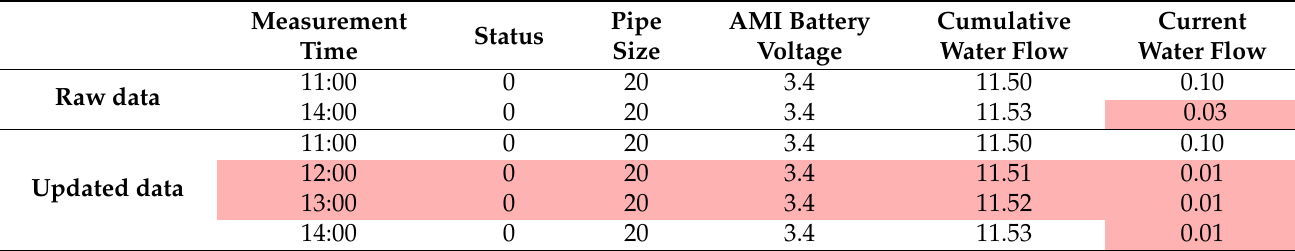
Figure 3. Mean square error results using various estimation methods for missing value estimation. Five estimation methods are compared. Table 3. Example of missing value estimation. The colored AMI data is estimated using the proposed missing value estimation